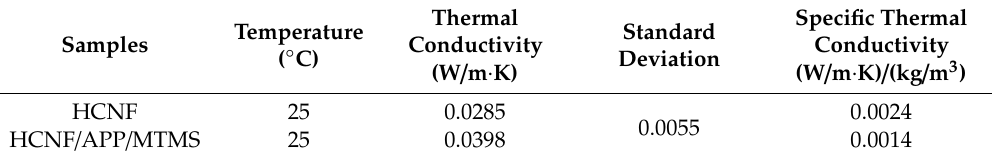
Table 4. The thermal conductivity of HCNF, and HCNF / APP / MTMS aerogels.